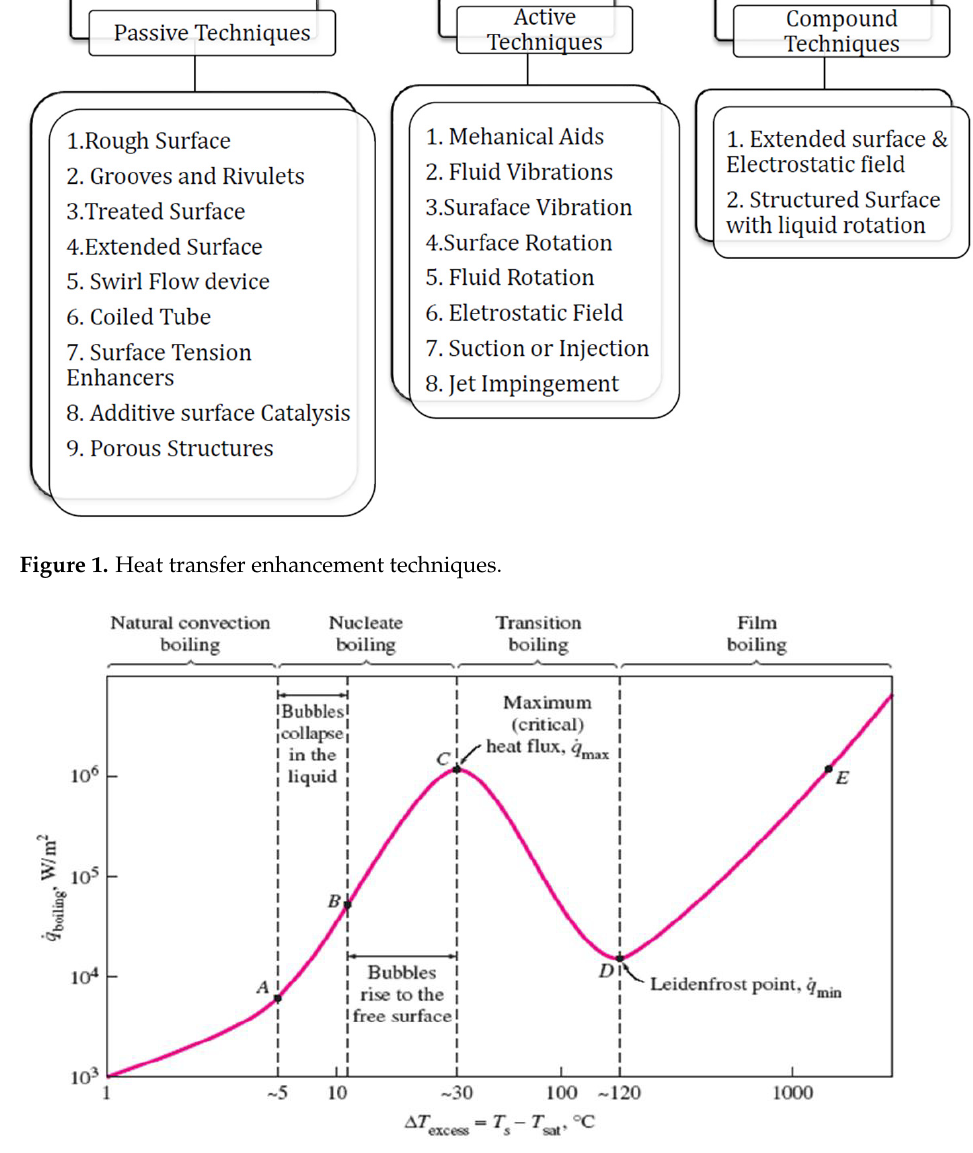
Figure 2. Boiling regimes, from Faghri & Zhang, 2006 [1].